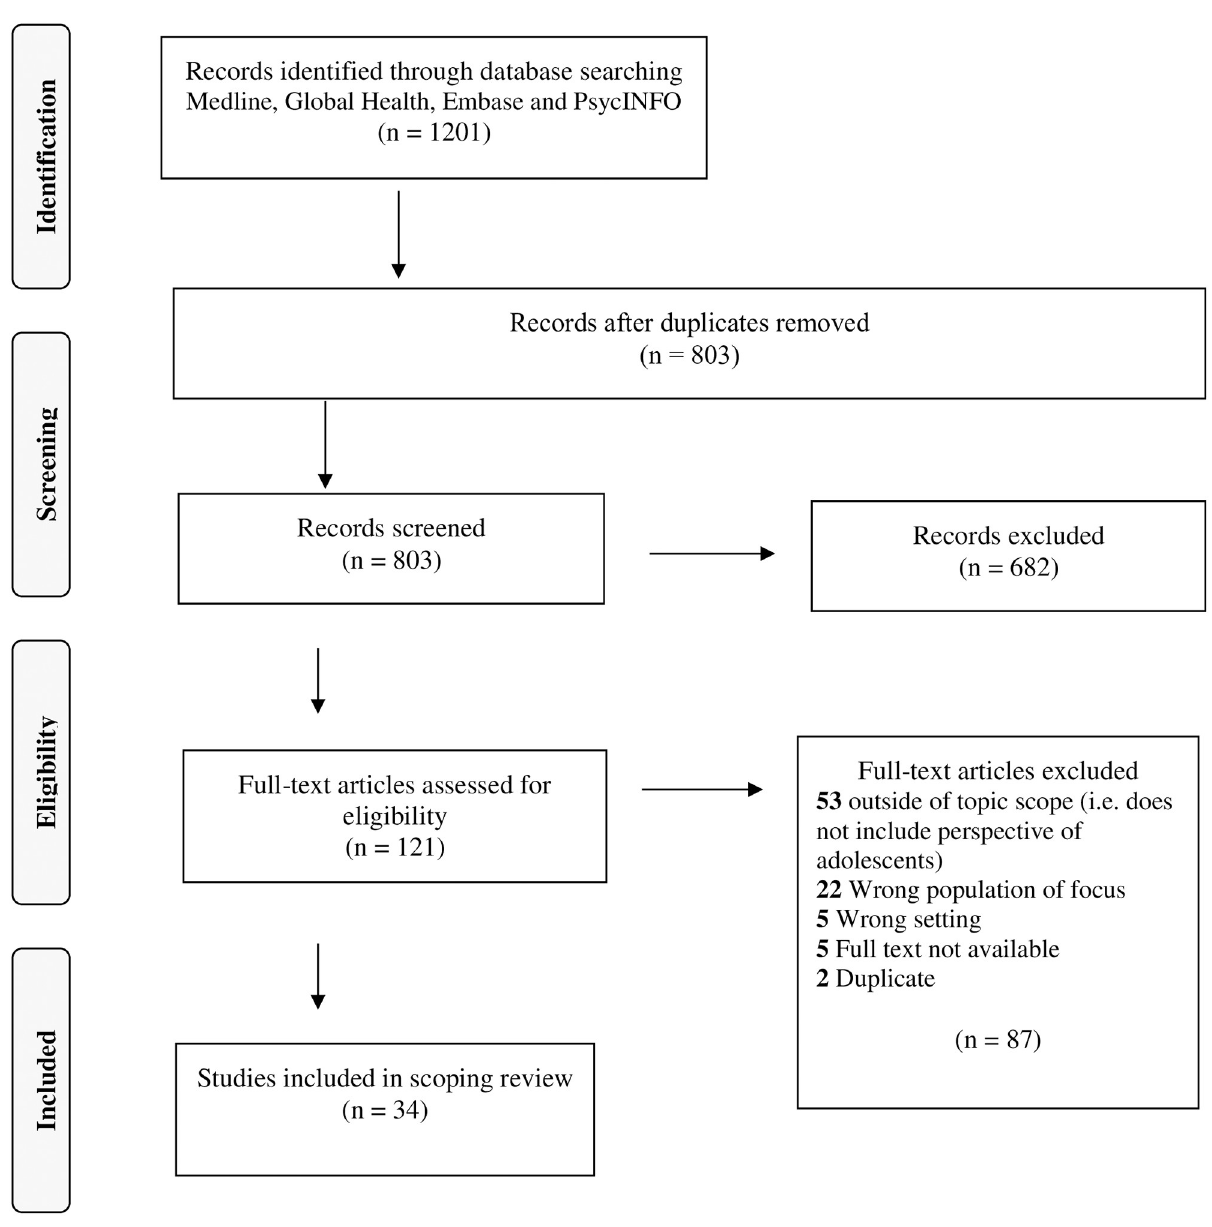
Fig 1. PRISMA flow